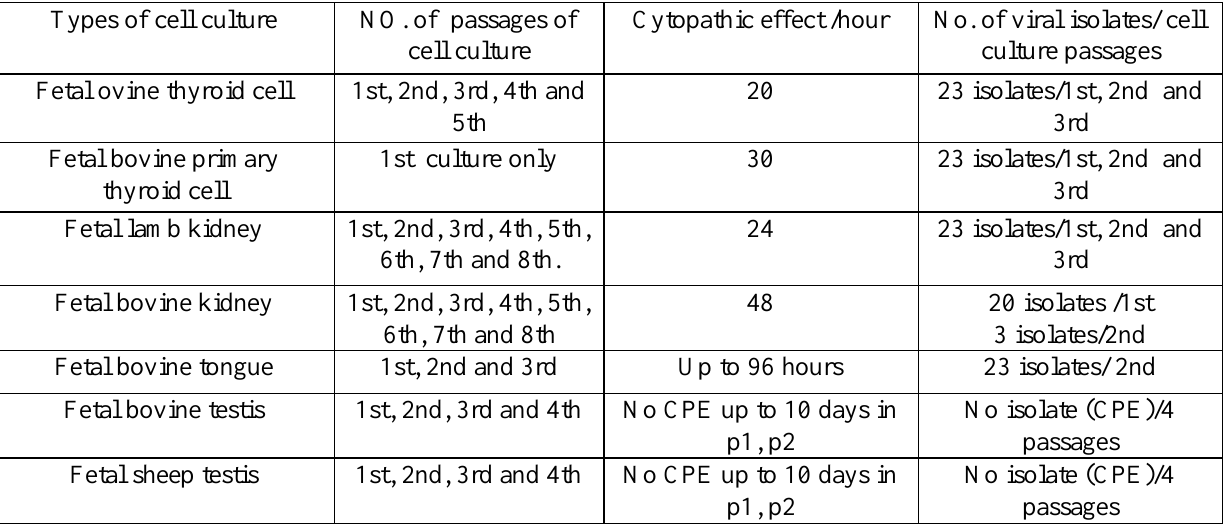
TABLE -1- The results of the isolation of the FMDv in different types of cell culture. Types of cell culture